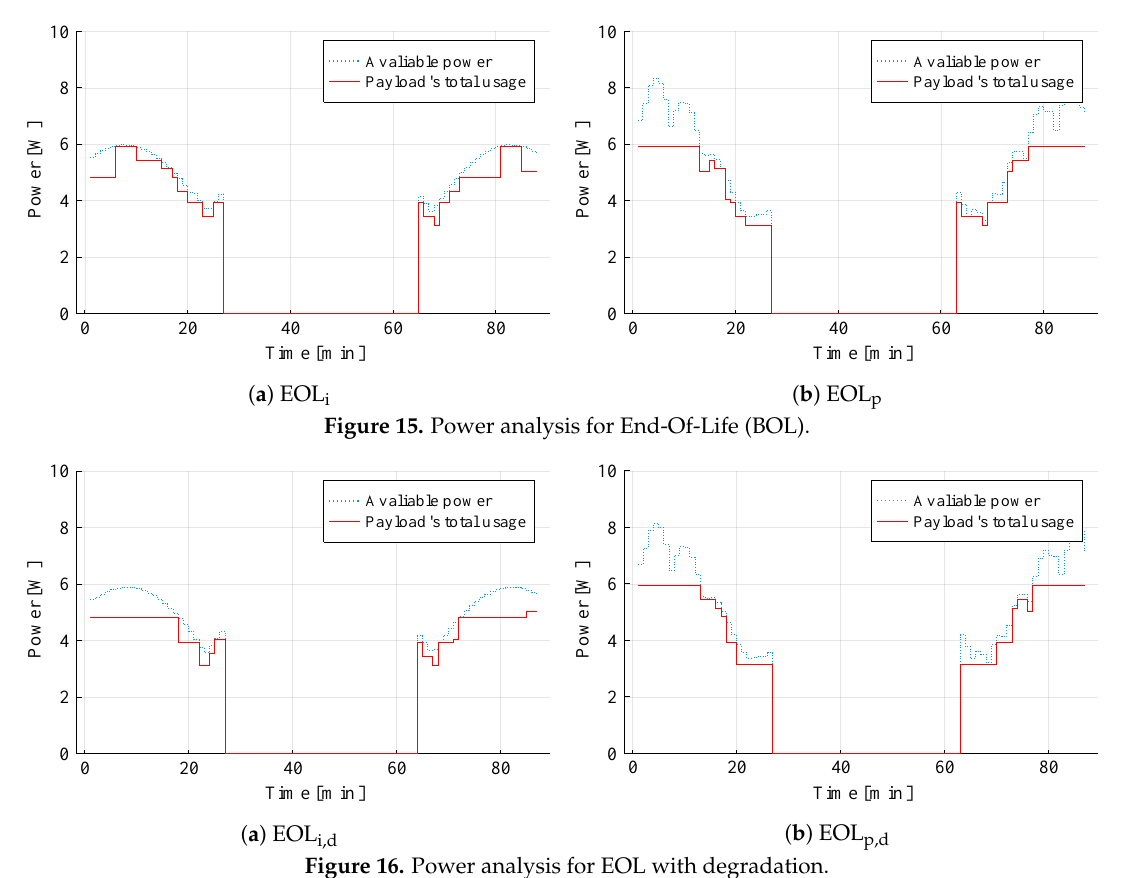
Figure 16. Power analysis for EOL with degradation.